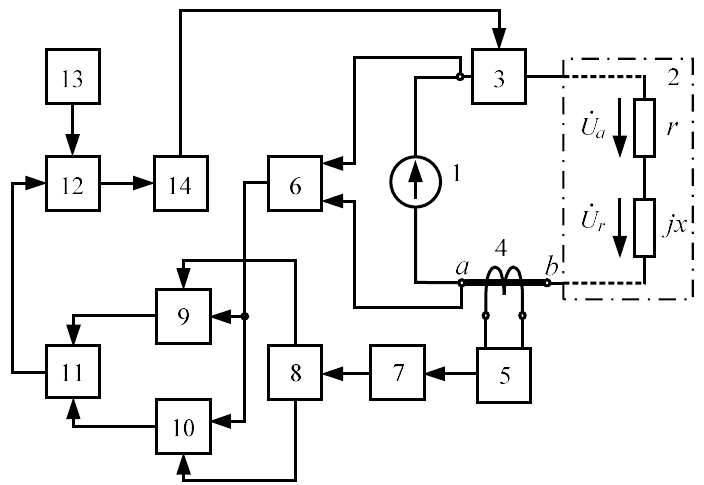
Figure 6. Block diagram of EM thermal protection device: 1, power supply of the EM stator winding (SW); 2, EM SW used as a temperature sensor; 3, EM SW switching device; 4, instrument current transformer (ICT); 5, current-to-voltage converter; 6, recorder attenuator; 7, phase shifter; 8, quadrature reference voltage generator; 9 and 10, synchronous detectors, respectively, of the in-phase and quadrature components of the EM SW power supply voltage; 11, ratiometric converter with digital output; 12, digital comparator; 13, block for setting the level of comparison; and 14, control signal generator.